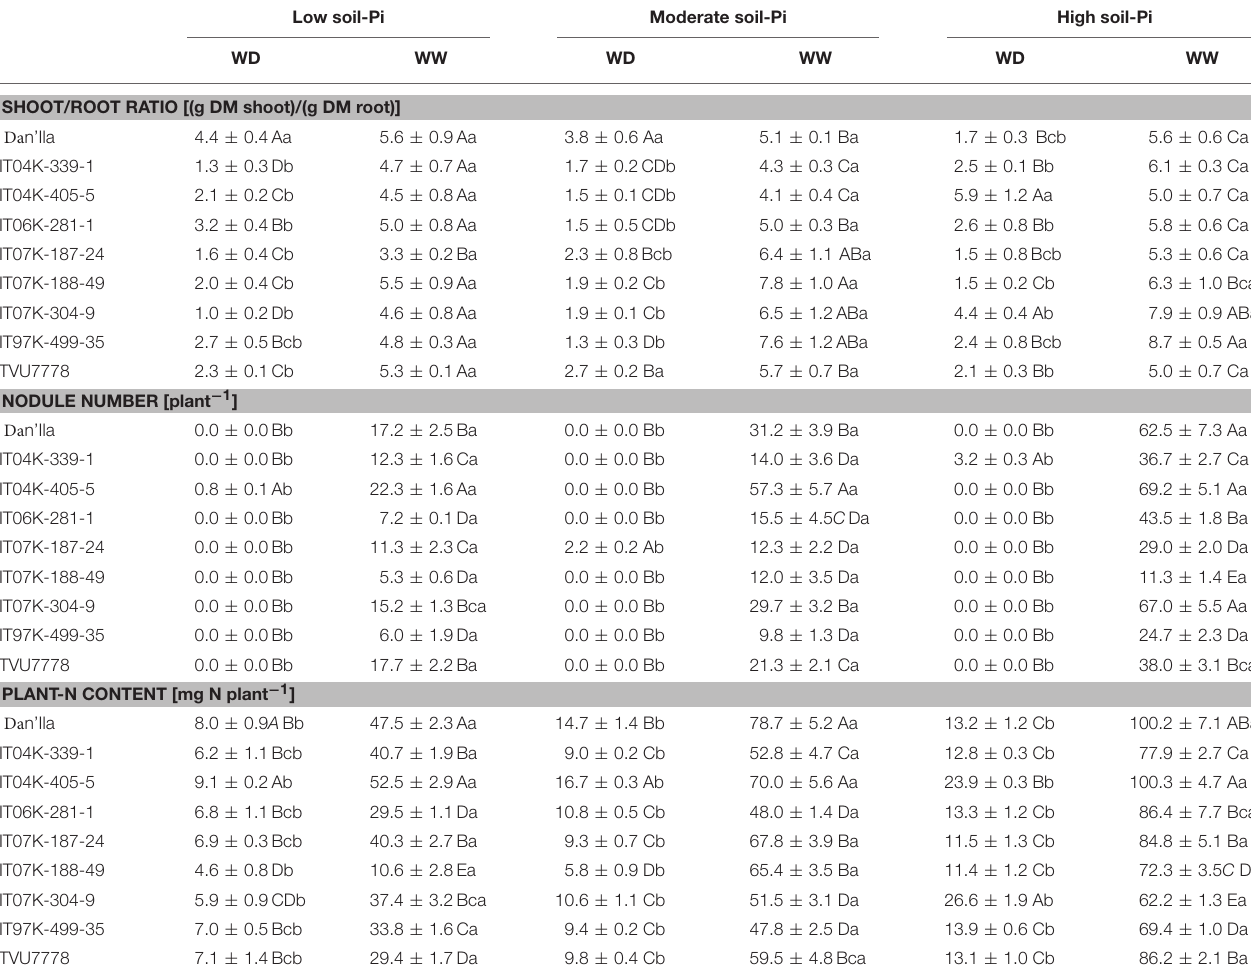
Mean values and standard errors are shown (n = 4). Different small letters indicate significant differences between the WD and WW plants for each variety at each available soil-Pi level (Fisher’s test; p < 0.05). Different capital letters indicate significant differences among the varieties at each available soil-Pi level and WD conditions (Fisher’s test; p < 0.05). DM, dry matter.